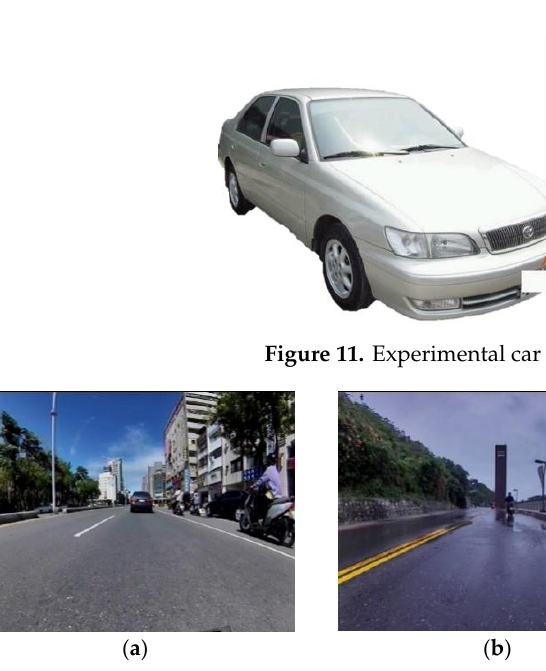
Figure 12. Daytime scenarios: ( a ) sunlight, ( b ) pavement puddle, and ( c ) shadow.